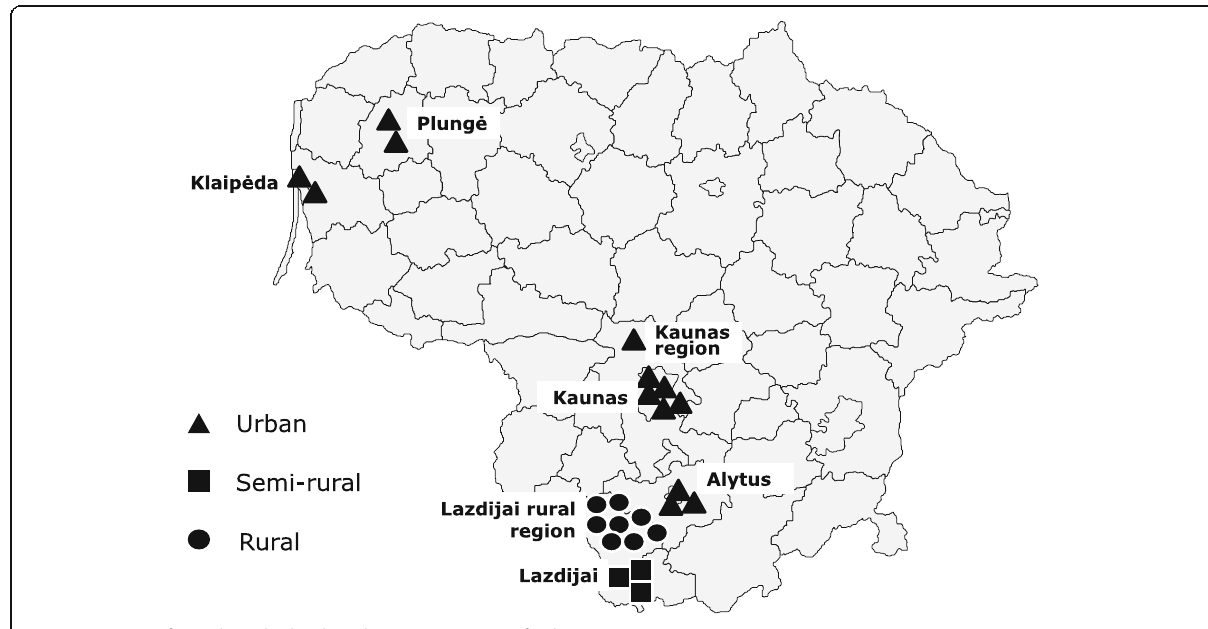
Fig. 1 Location of 24 selected schools within seven regions of